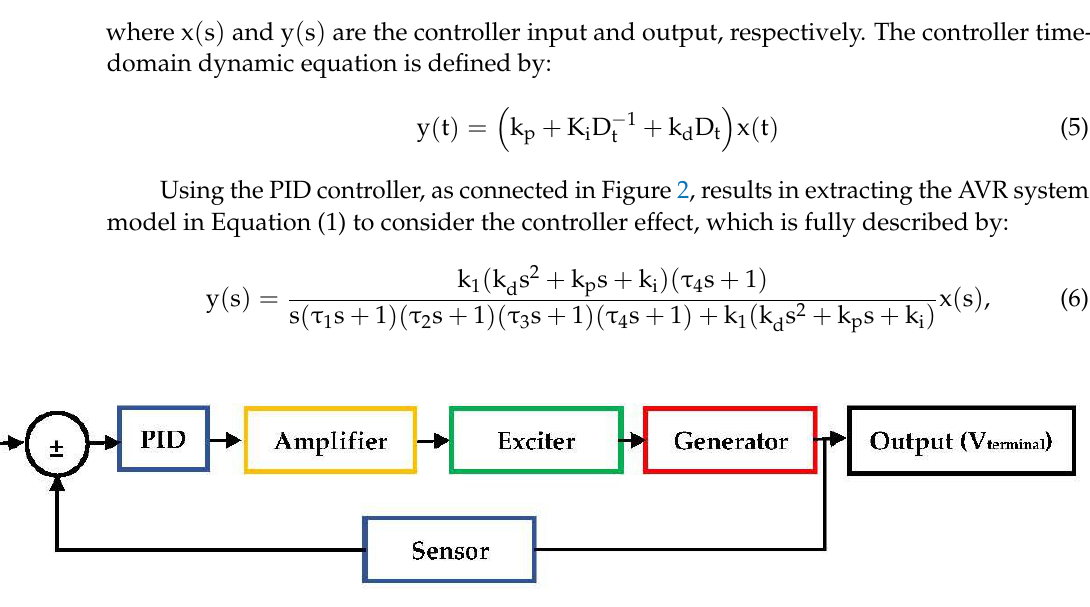
Figure 2. Block diagram of PID-AVR system.